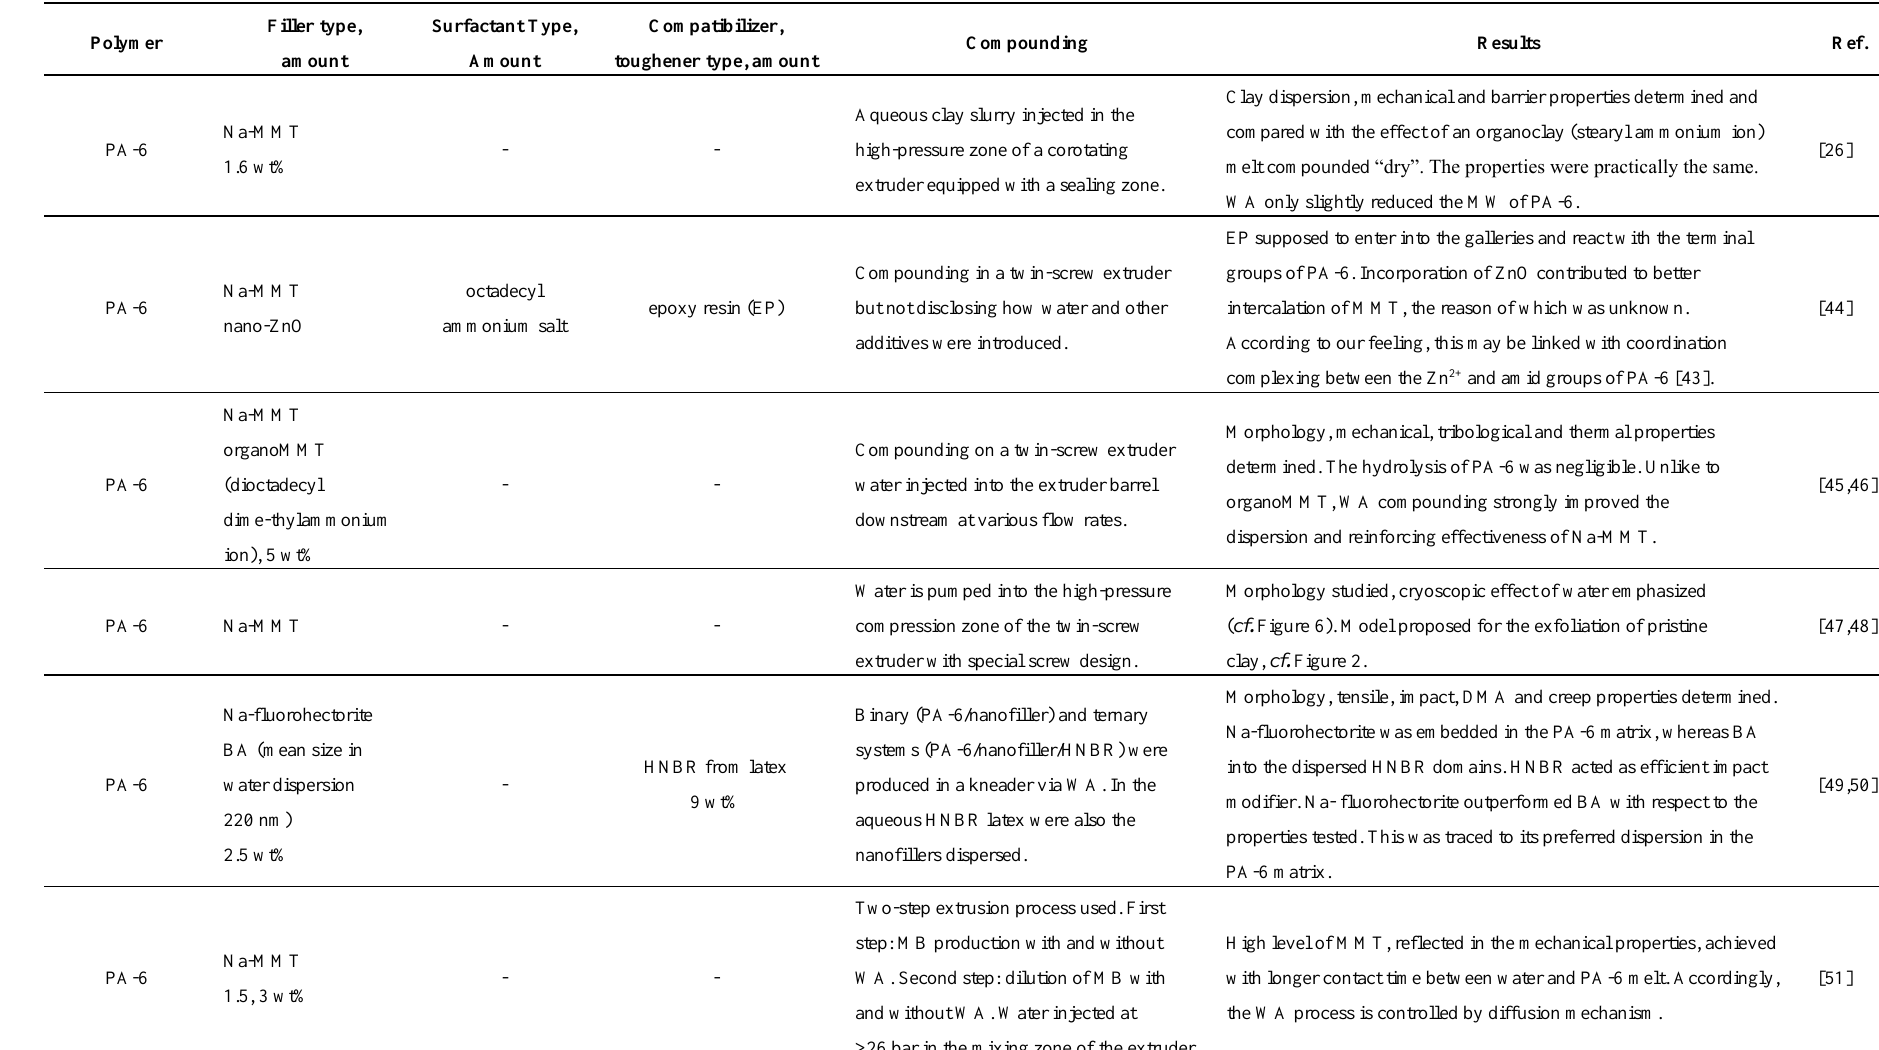
Table 2. Water-assisted (WA) melt compounding of engineering